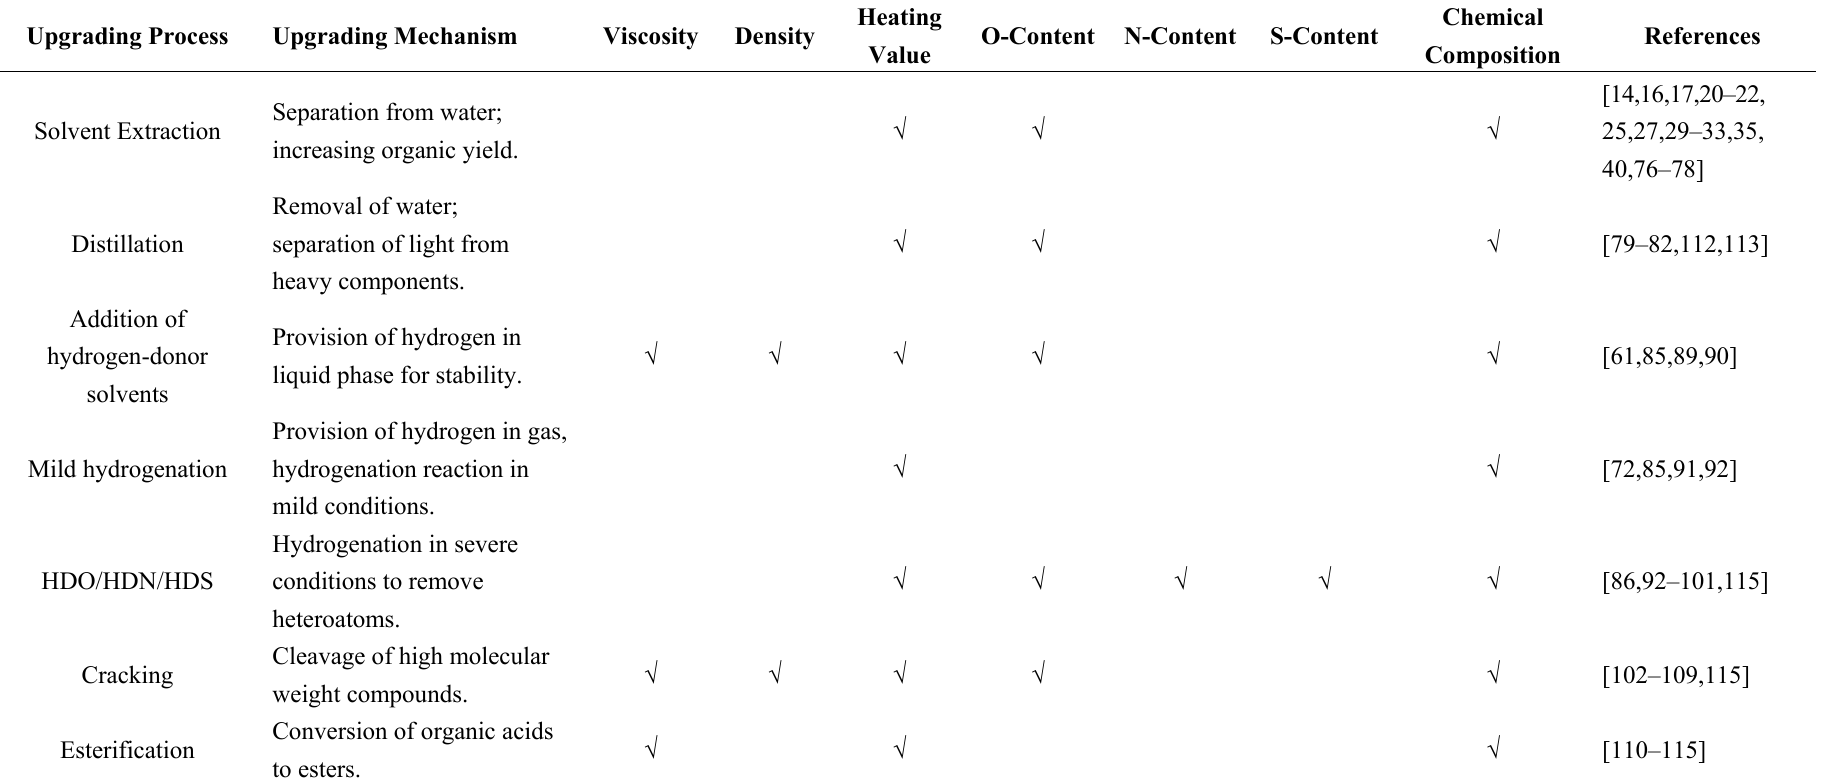
Table 6. Upgrading processes and their effect on physical and chemical properties. Direct influence of processes to bio-crude property towards standard